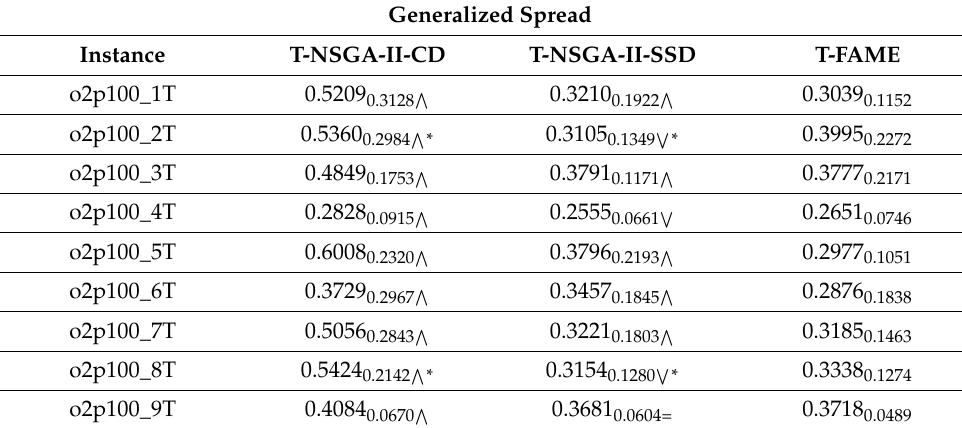
Table 14. Results with the generalized spread metric.